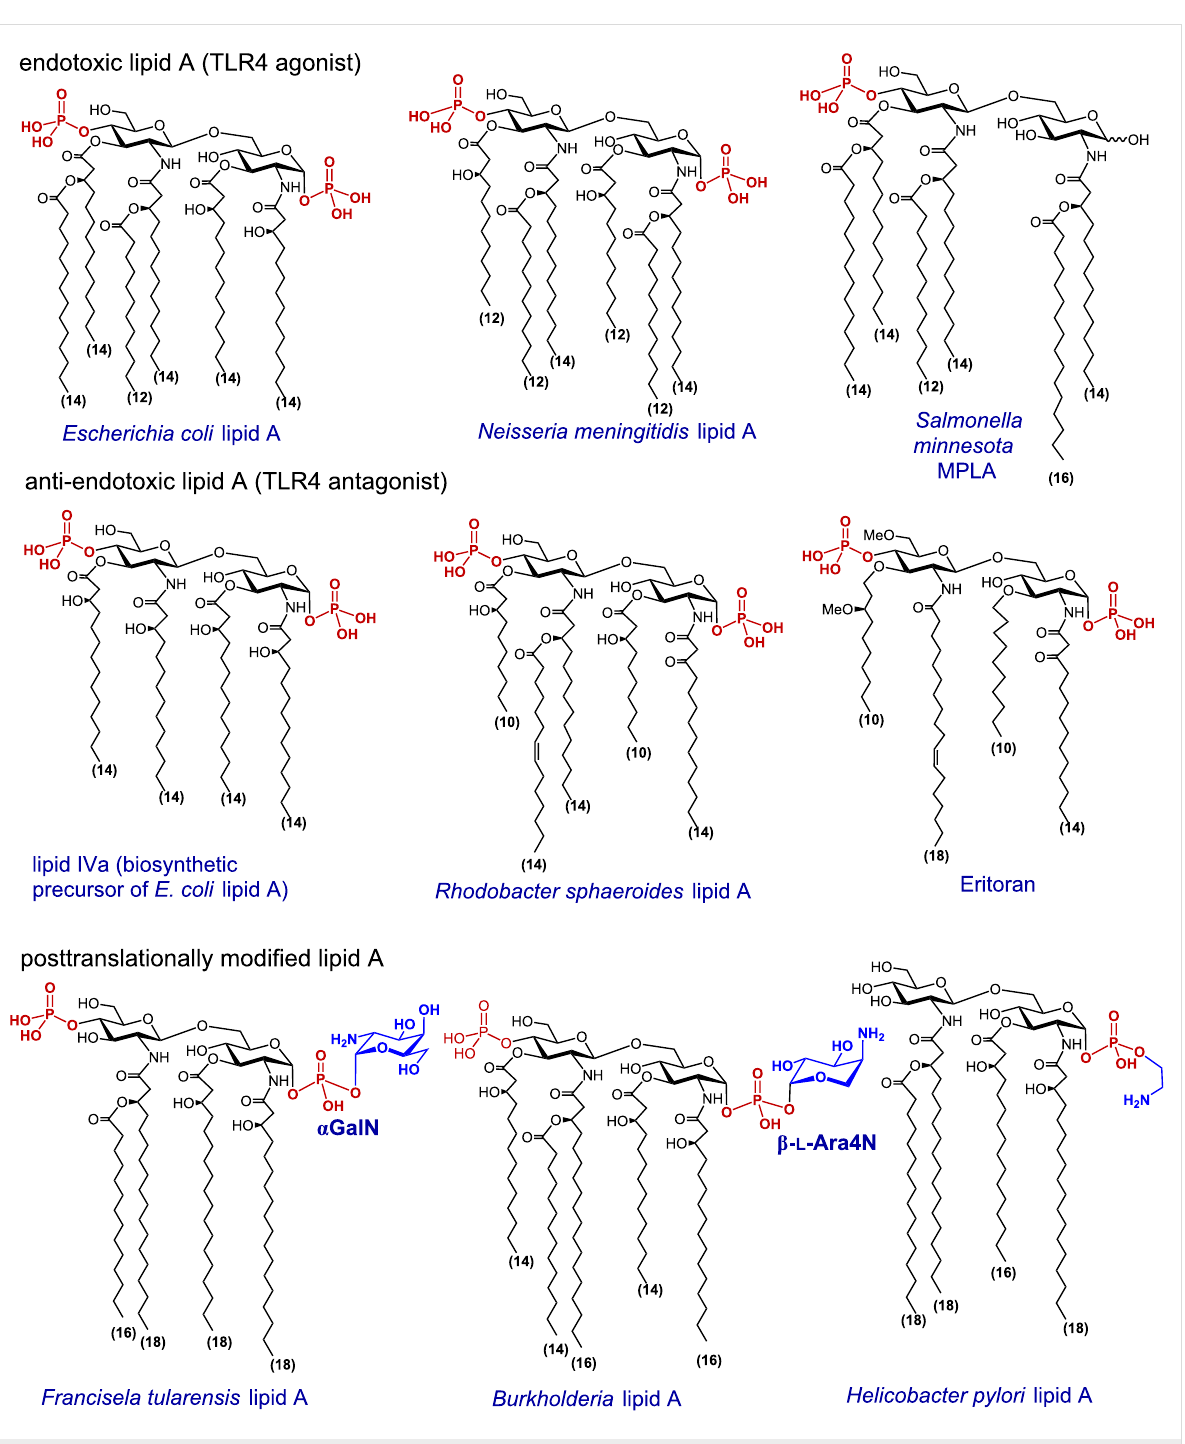
Figure 2: Structures of representative TLR4 ligands: TLR4 agonists ( E. col i lipid A, N. meningitidis lipid A and MPLA) and TLR4 antagonists (lipid IVa, R. sphaeroides lipid A and eritoran (E5564)); examples of post-translationally modified lipid A from Francisella , Burkholderia and Helicobacter .